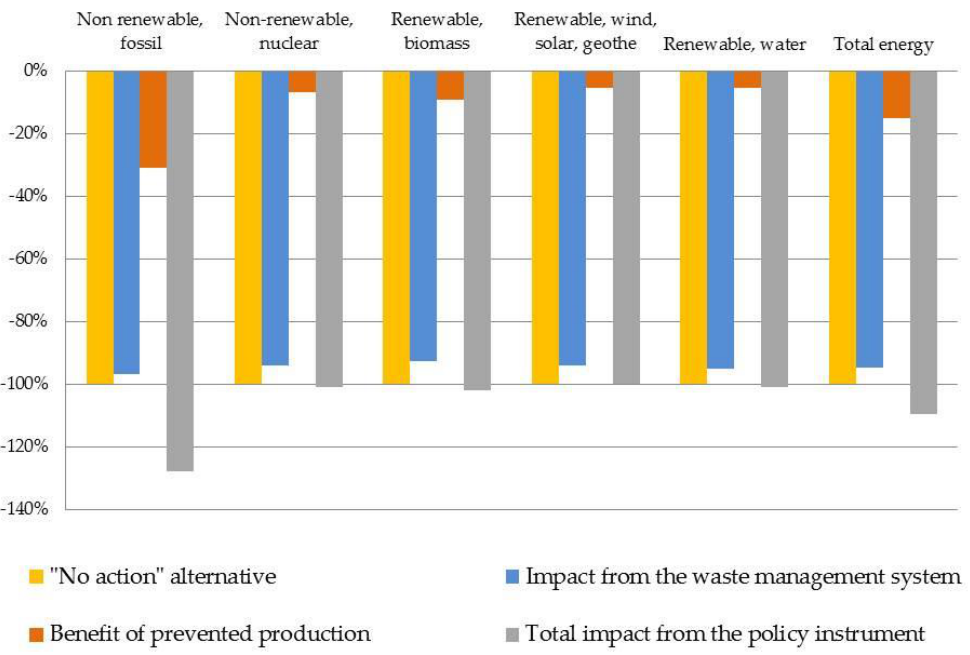
Figure 6. Relative results for the Cumulative energy demand for Weight based waste fee, alt.1 policy instrument compared to the “no action” alternative set to 100%